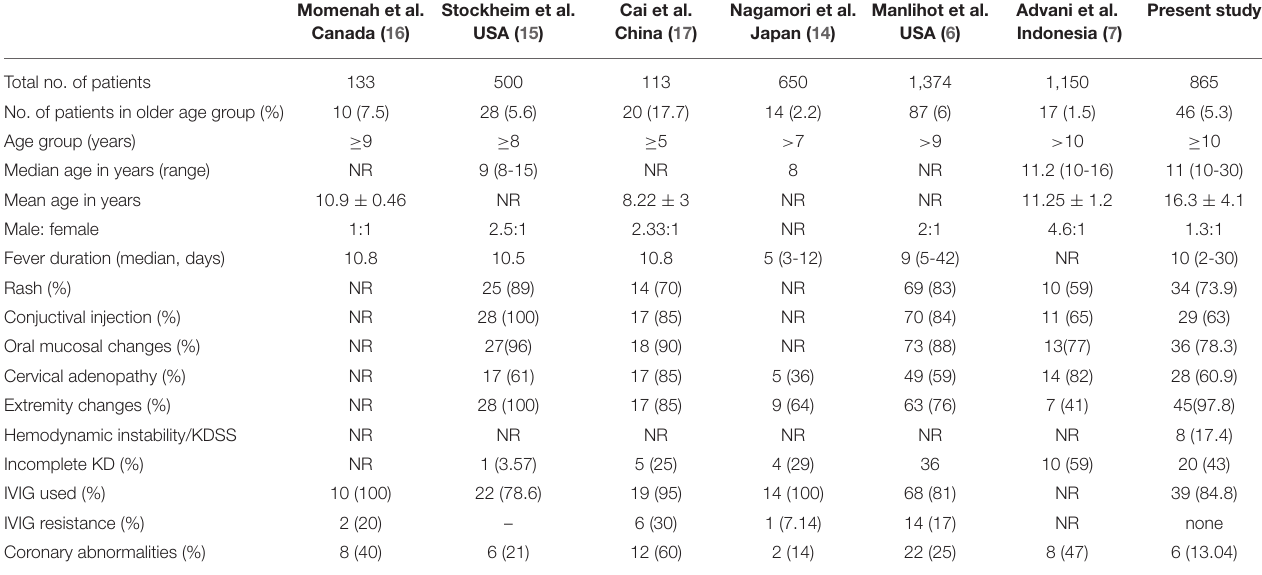
TABLE 5 | A review of all reported studies on Kawasaki disease in older age groups.